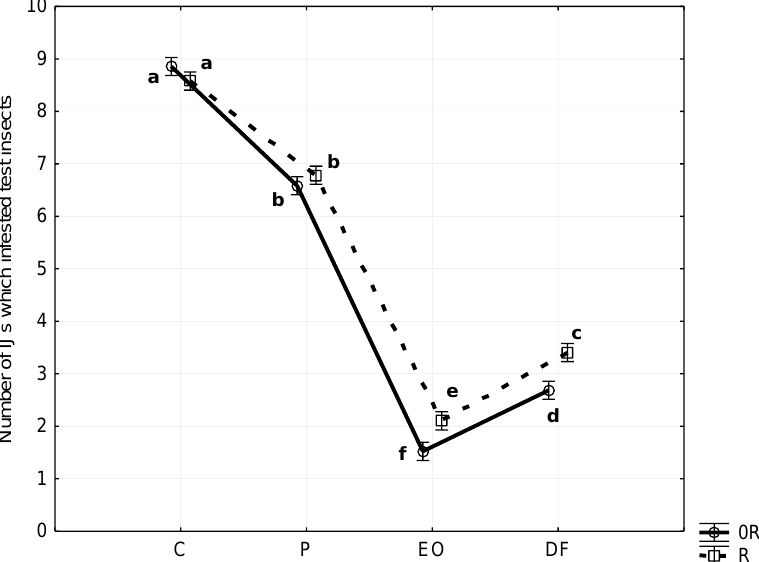
Figure 2. The intensity of penetration of test insects ( T. molitor ) by S. feltiae IJs, average for the investigated period. C — unpolluted soil, P — soil contaminated with petrol, EO — soil contaminated with used engine oil, DF — soil contaminated with diesel fuel, 0R — series without bioremediation, R — series with bioremediation. Means marked with the same letters do not significantly differ according to NIR test at α = 0.05; factors contamination x remediation. Table 2. The effect of oil derivatives on the intensity of penetration of test insects ( T. molitor ) by S. feltiae IJs. Months from the Moment Soil Was Contaminated